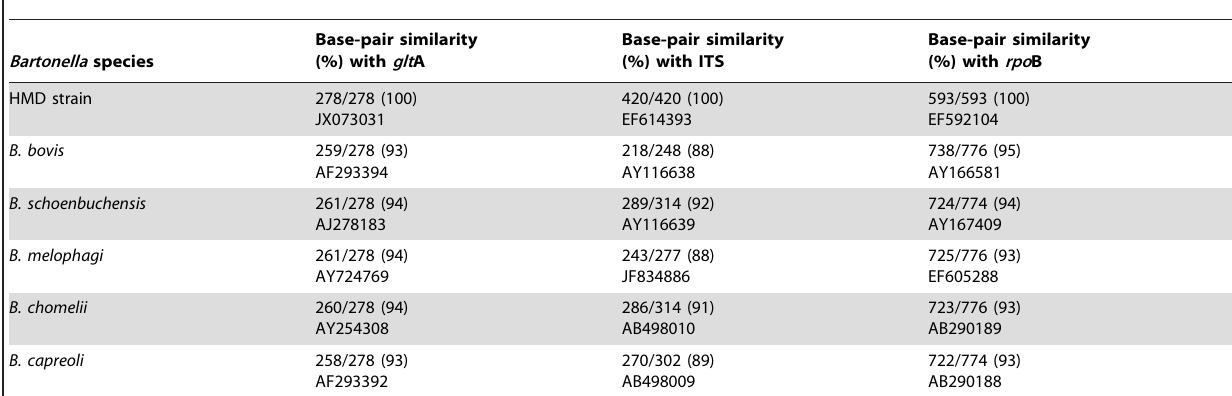
Table 3. Similarity between dog strain F059 and closest Bartonella species for glt A, ITS and rpo B*.